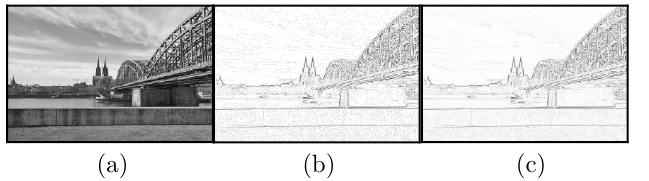
Figure 13. Edge detection outcome using SC Roberts edge detection circuit for different bit-precision: Input image ( a ); and output image for 4-bit precision ( b ) and 8-bit precision ( c ), using the proposed LFSR seeding method.